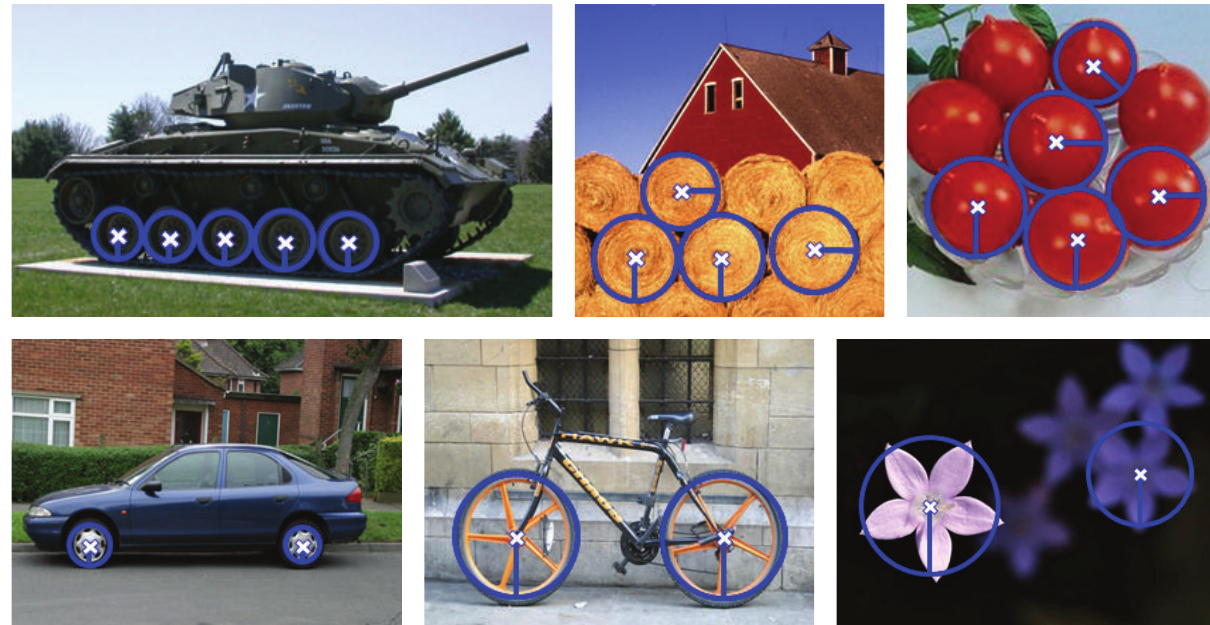
Figure 7: Results of images with multiple rotational symmetry.